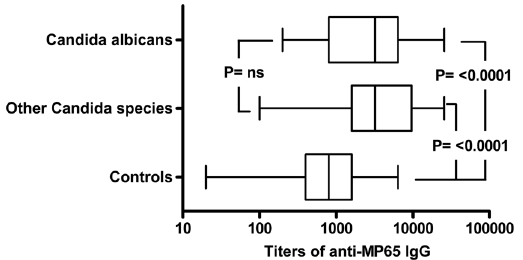
Figure 3. Levels of anti-MP65 IgGs are comparably increased in patients infected by C . albicans or by other, non- albicans , Candida species. The plot compares the distribution of anti-MP65 IgG titers in patients with C . albicans candidemia (n = 43), patients infected by other Candida species (n = 28) and non-candidemic controls (n = 69). Bottom and top of the box represent the first and third quartiles, respectively. Line inside the box is the median titer and whisker show minimum and maximum values. P was calculated by Kruskal-Wallis ANOVA and Dunn’s post-test.